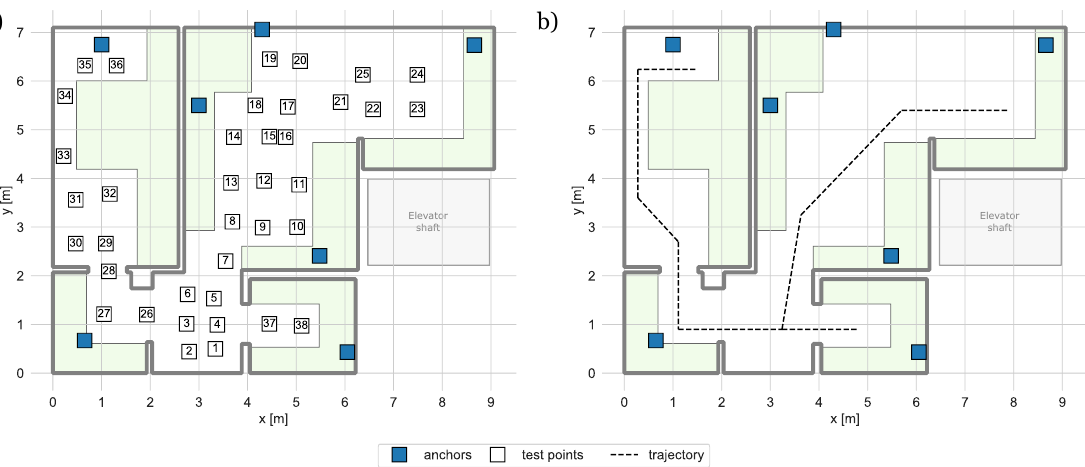
Figure 9. System layout during accuracy and precision tests: green shaded areas represent furniture: ( a ) location of test points, ( b ) reference movement